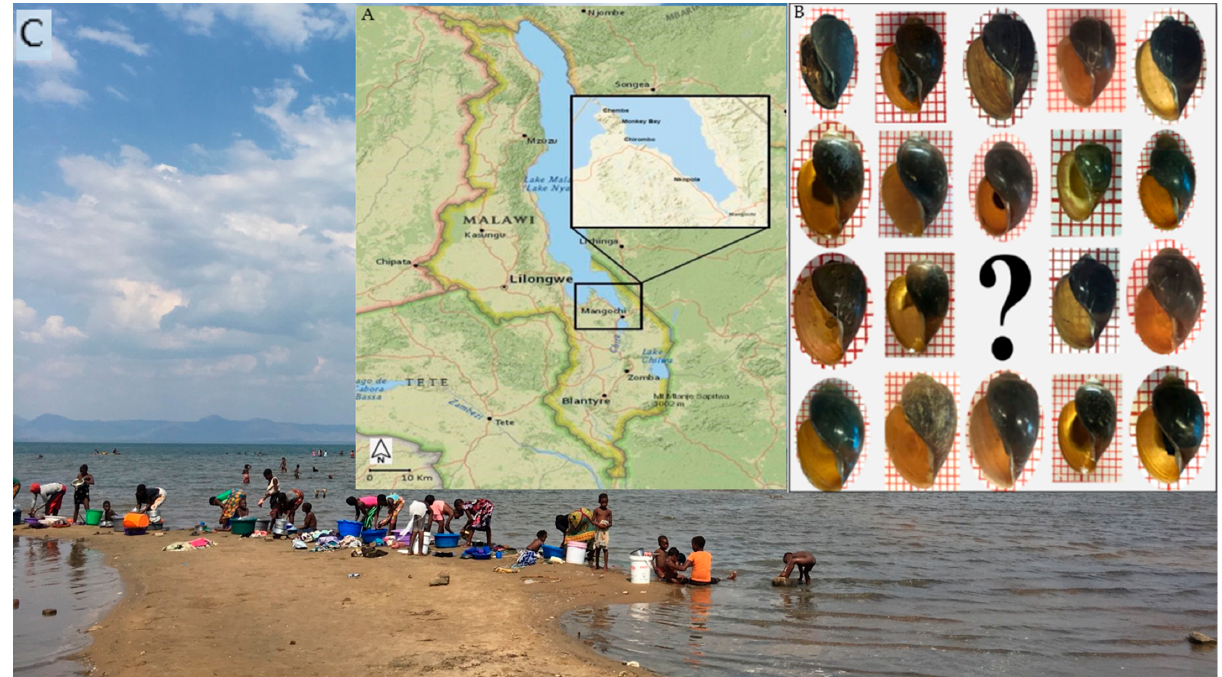
Figure 1. ( A ) Map of Malawi adapted with a highlight of Mangochi District, where the malacological surveys were conducted in 2017 and 2018. ( B ) B. africanus shells collected from Lake Malawi were investigated in this study. ( C ) Pictures from locations visited in 2017 and 2018 show the extensive water contact by local communities.